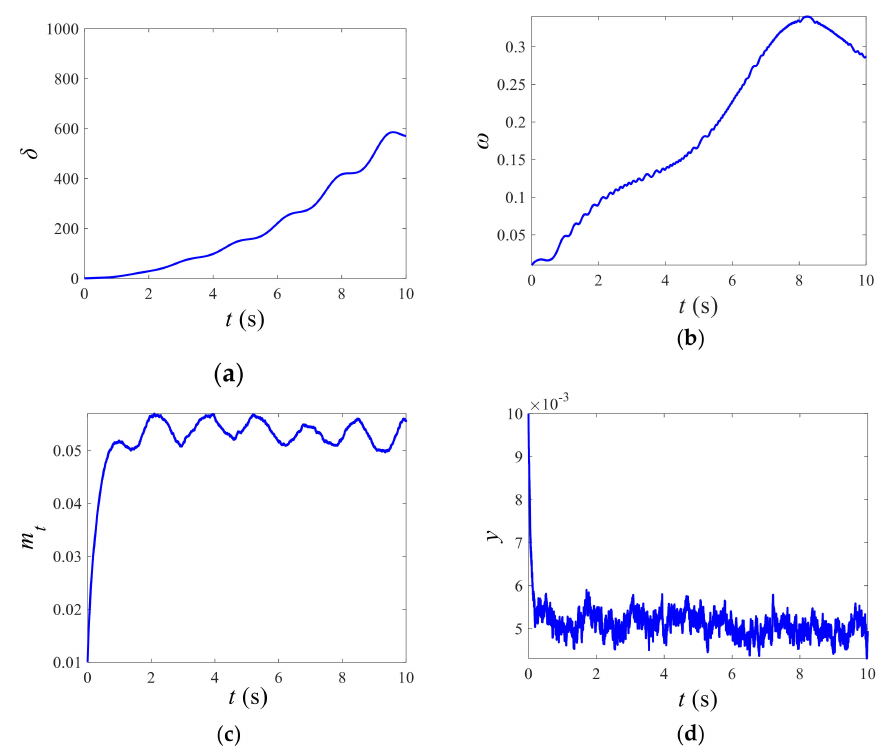
Figure 2. State trajectories of the hydraulic-turbine-governing system (HTGS) without a